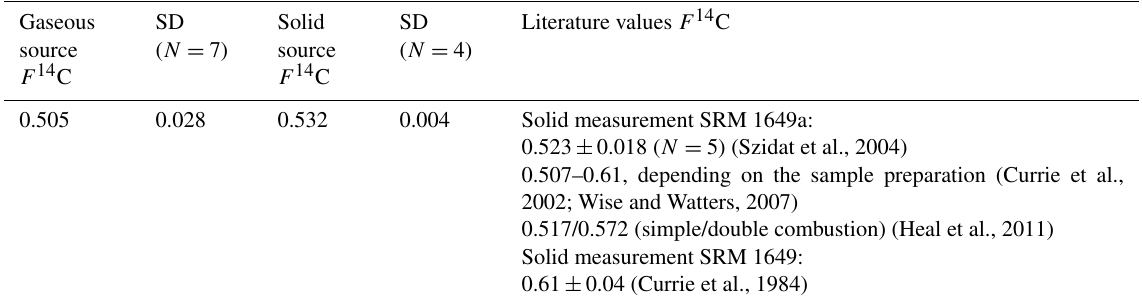
Table 2. Analyses of SRM1949b with gaseous and solid (roughly 1mgC) source. Gaseous measurements are made with punches of loaded quartz filters. Comparison with the literature values for SRM 1649 and SRM